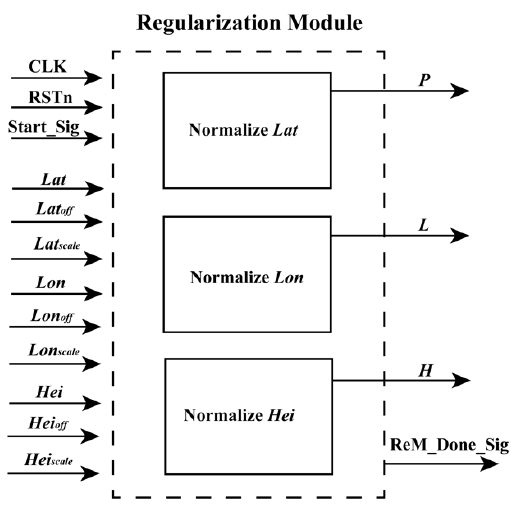
Figure 3. Schematic diagram of the ReM.